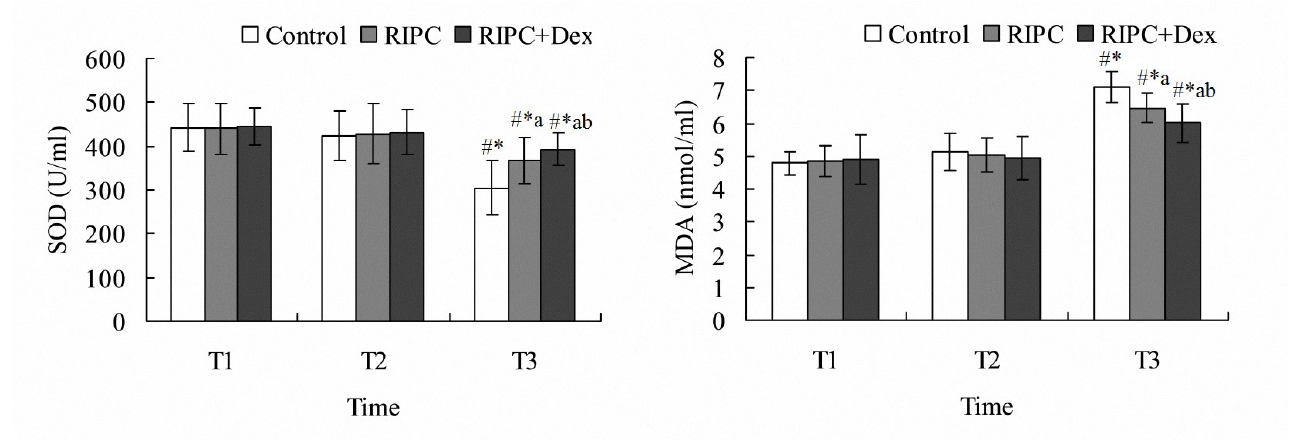
FIGURE 2 - Comparison of serum SOD and MDA levelsamong three groups. # P < 0.05 compared with T1; * P < 0.05 compared with T2; a P < 0.05 compared with control group; b P < 0.05 compared with RIPC group. SOD, superoxide dismutase; MDA, malondialdehyde.